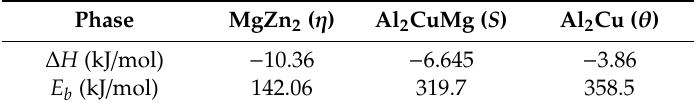
Table 4. Formation enthalpy ∆ H and binding energy E b of metal intermediate phase.